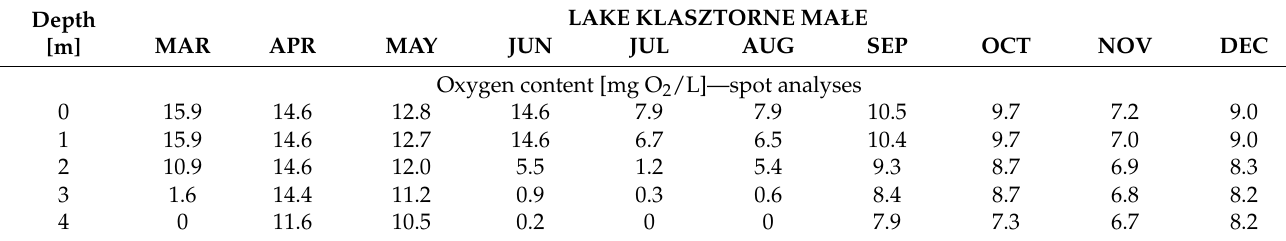
Table 1. Oxygen settings in analyzed